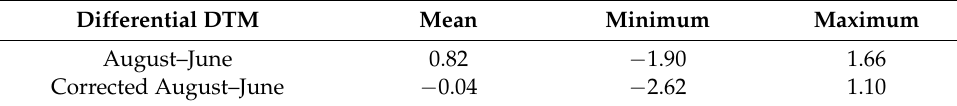
Figure 16. Differential DTMs: differential DTM without correction ( a ), and differential DTM ob- tained from the corrected August DTM ( b ).